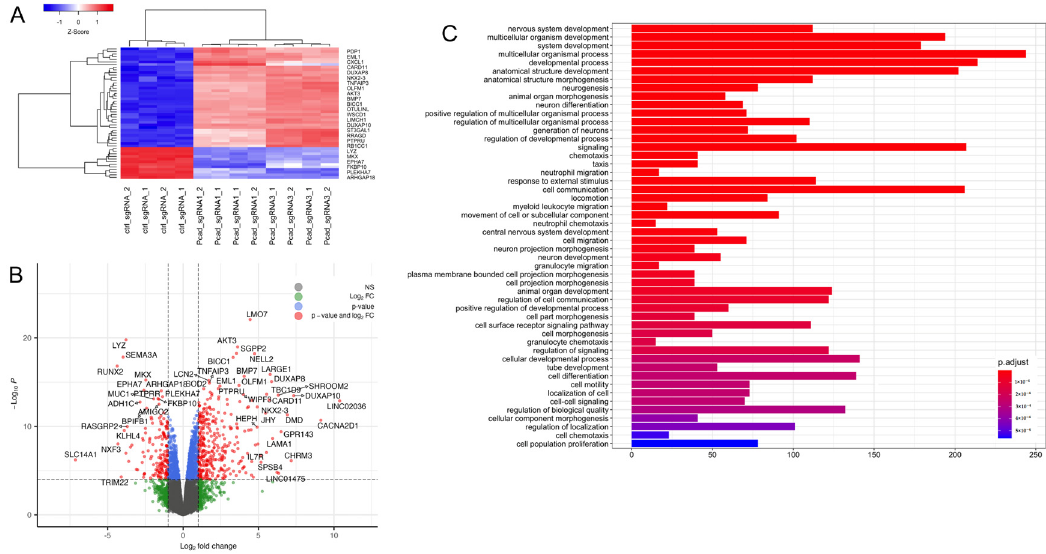
Figure 9. Rac1 activation mediates the increased wound healing in P-cadherin deficient IEC monolayers. ( A ) G-LISA assay shows Rac1 activation in P-cadherin knockout HCA-7 cells. Control and P-cadherin knockout HCA-7 cell monolayers were wounded and allowed to migrate in the presence of either vehicle, or Rac1 inhibitor, EHT 1864 (50 μ M). Representative pictures of wounded monolayers ( B ) and quantification of wound closure ( C ) are shown. Means ± SE ( n = 4); ** p < 0.01, *** p < 0.005. Scale bar, 100 μ m. The results shown are representative of two independent experiments.